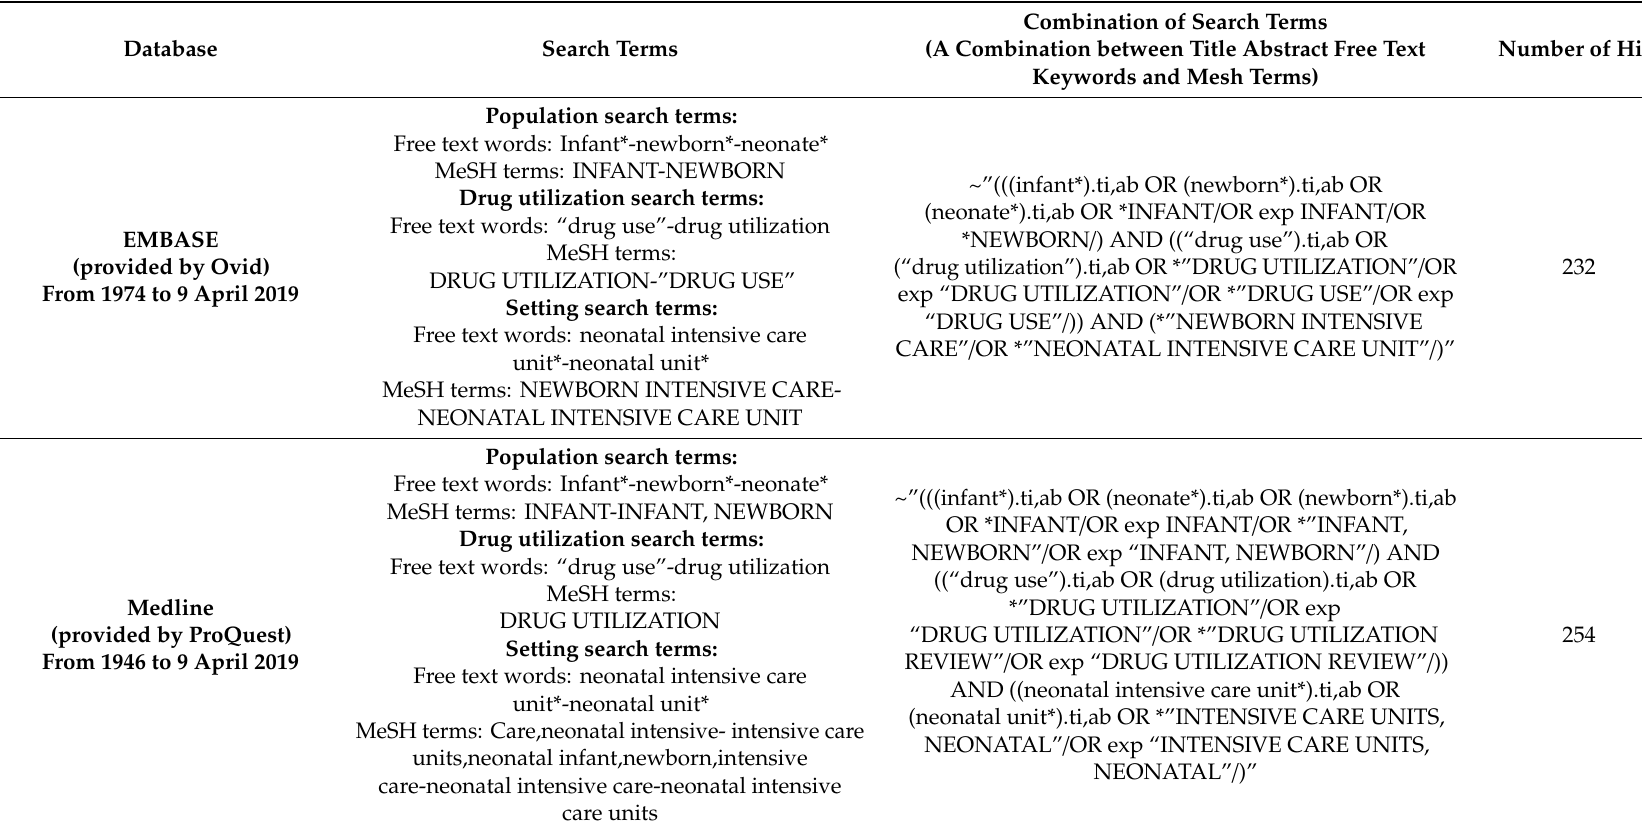
Table A1. Search strategy for drug utilization review (from inception of database to February 2019 using OR,